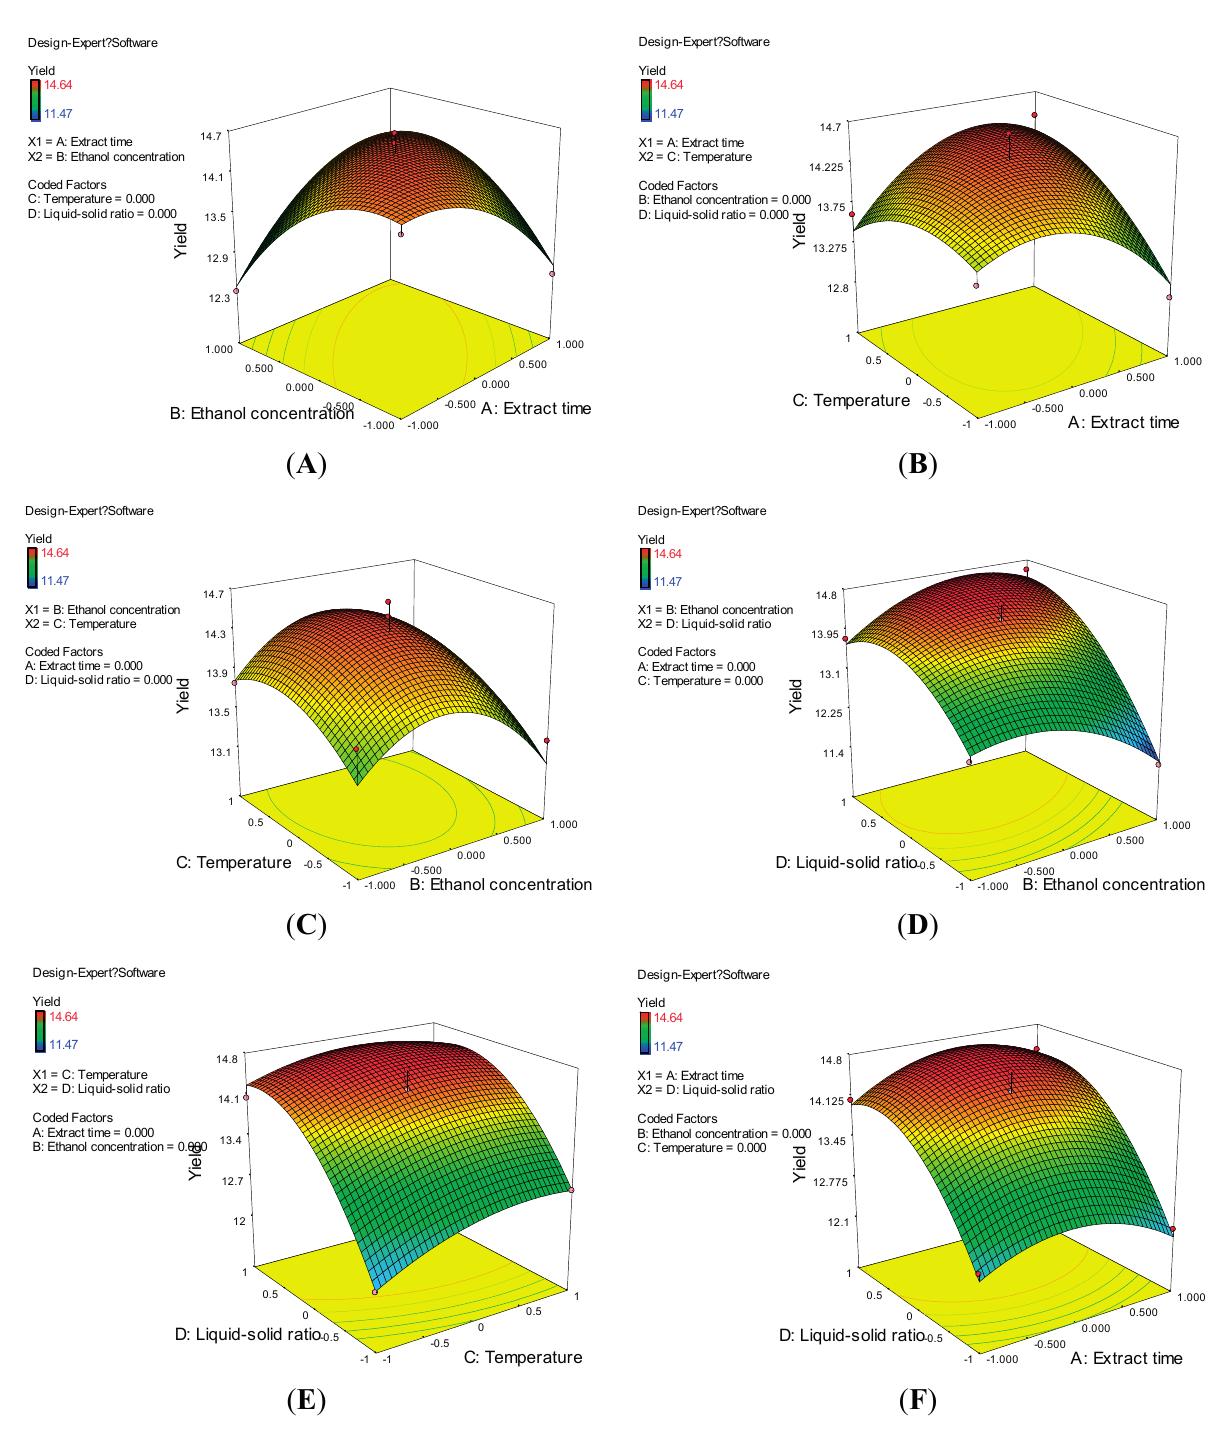
Figure 1. Response surface (3-dimensional) showing the effects of process conditions on the extraction yield of astilbin. ( A ) ethanol concentration-extraction time; ( B ) temperature-extraction time; ( C ) temperature-ethanol concentration; ( D ) liquid-solid ratio-ethanol concentration; ( E ) liquid-solid ratio-temperature; ( F ) liquid-solid ratio-extraction